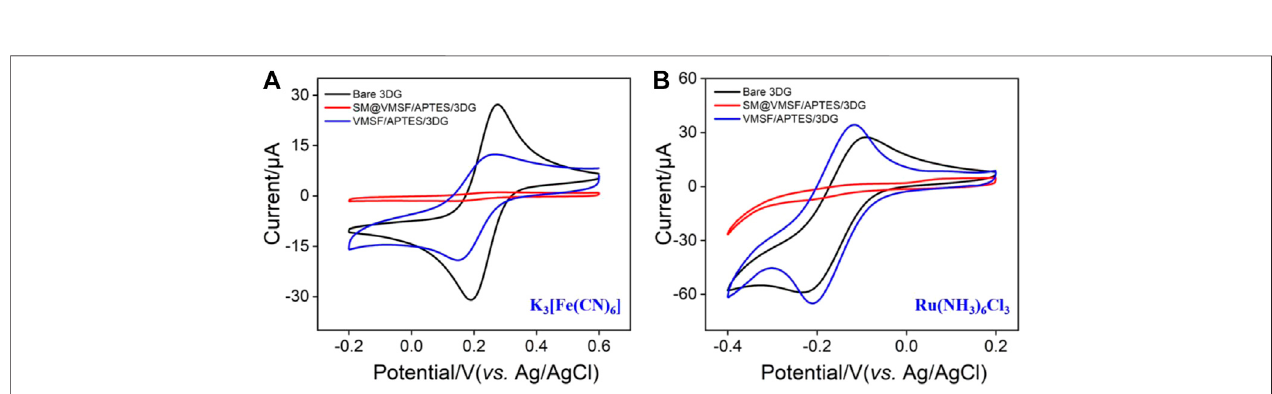
FIGURE 4 | CV curves obtained at bare 3DG, SM@VMSF/APTES/3DG, and VMSF/APTES/3DG in 0.05 M KHP solution containing 0.5 mM K 3 [Fe(CN) 6 ] (A) and 0.5 mM hexaammineruthenium III chloride (Ru(NH 3 ) 6 Cl 3) (B) . The scan rate was 50 mV s − 1 .